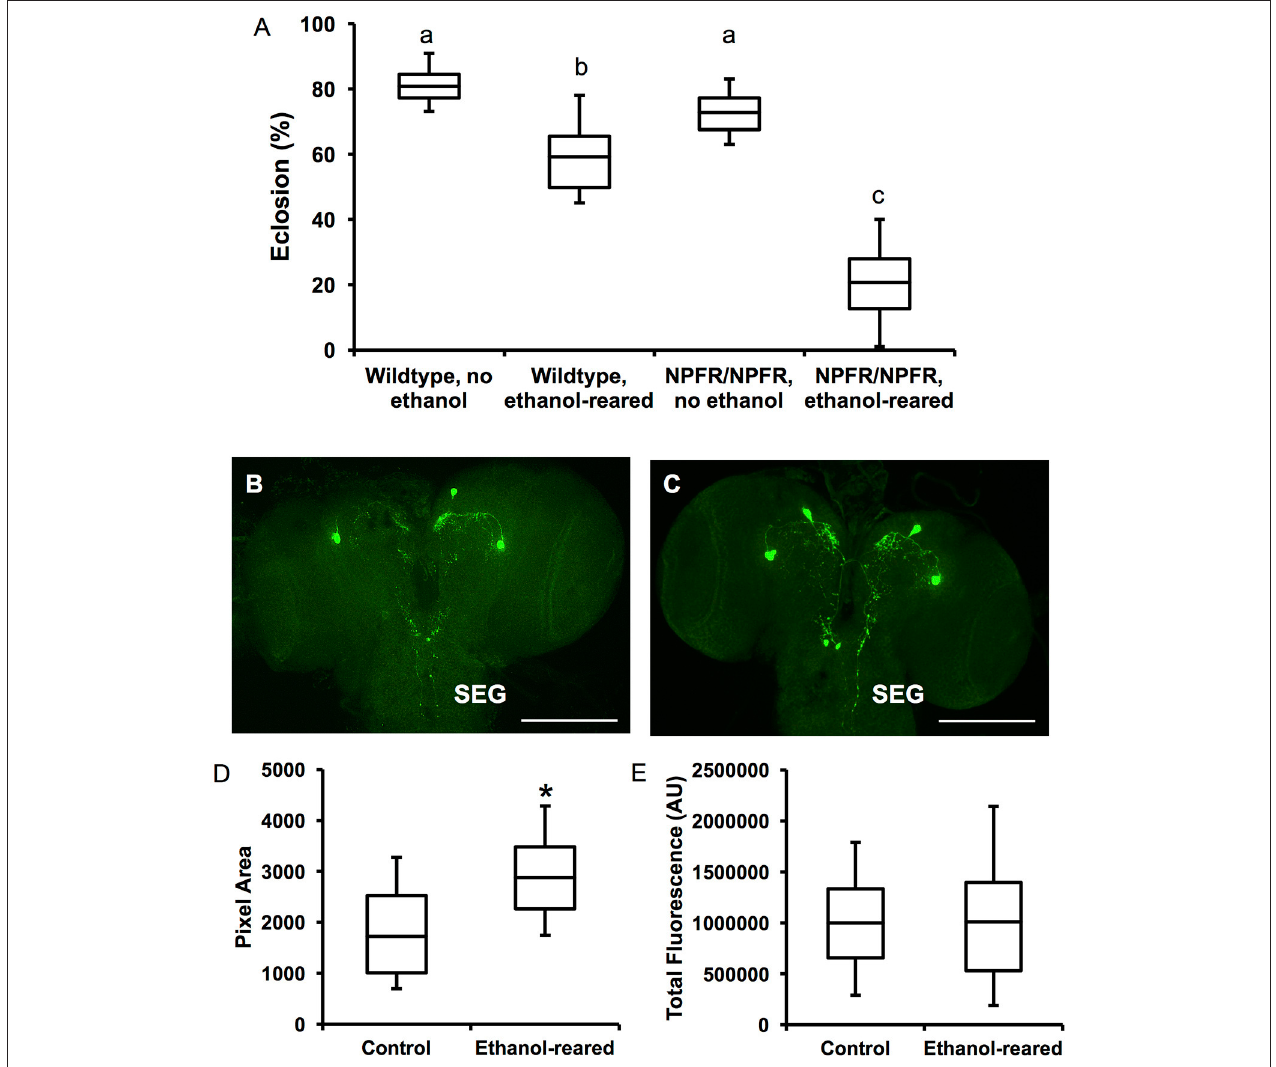
FIGURE 4 | npfr1 is necessary for survival of ethanol-supplemented flies, and developmental ethanol exposure induces a change in NPF distribution in larval brains. (A) Survival to adulthood of npfr1 mutant flies reared in ethanol. ( N = 12 for all conditions and genotypes, P < 0.0001 for the effect of ethanol-rearing, P < 0.0001 for the effect of mutation of npfr1 , and P < 0.0001 for the interaction between treatment and genotype, two-way ANOVA with Tukey’s post-hoc analysis.) Boxes sharing the same letter do not differ significantly, while boxes with different letters are significantly different ( P < 0.05). (B) Confocal reconstruction of NPF - expressing neurons in the brain of a 3rd-instar larva reared in ethanol-free control food. Scale bar = 0.5 µ M. (C) Confocal reconstruction of NPF-expressing neurons in the brain of a 3rd-instar ethanol-reared larva. Scale bar = 0.5 µ M. (D) Quantitation of pixel area for anti-NPF fluorescence in control and ethanol-reared third-instar larval brains. ( N = 7 brains for each condition, P = 0.0473, Student’s t -Test). (E) Quantitation of total anti-NPF fluorescence in control and ethanol-reared third-instar larval brains. ( N = 7 brains for each condition, P = 0.97, Student’s t -Test.) Center lines show the sample mean; box limits indicate the 25th and 75th percentiles as determined by